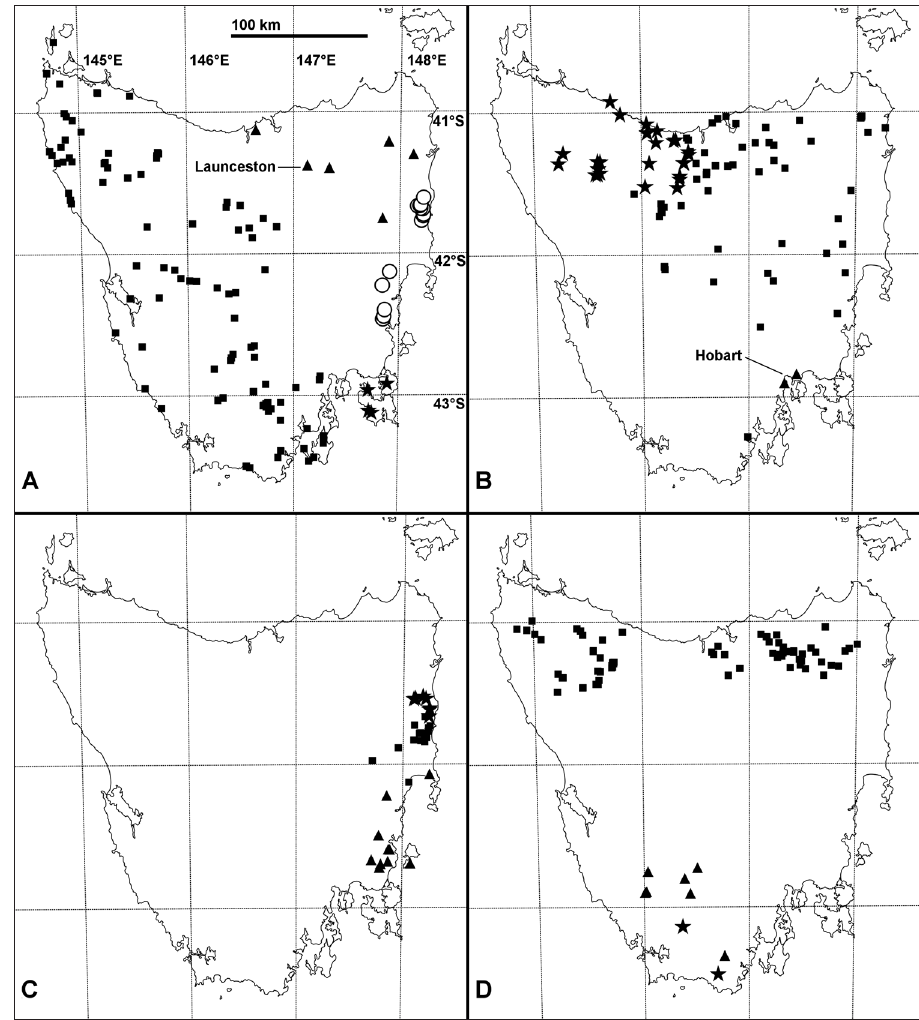
Figure 7. Known localities as of 14 July 2016 for Tasmanian Iulomorphidae; Mercator projections with approximate distance scale. A Amastigogonus orientalis sp. n. (open circles), A. peninsulensis sp. n. (stars), A. tasmanianus Brölemann, 1913 (triangles), A. verreauxii (Gervais, 1847) (squares) B Amastigogonus fossuliger Verhoeff, 1944 (squares), A. hardyi (Chamberlin, 1920) (triangles), A. hellyeri sp. n. (stars) C Amastigogonus danpicola sp. n. (squares), A. elephas sp. n. (stars), A. michaelsae sp. n. (triangles) D Atelo- mastix bonhami sp. n. (triangles), A. smithi sp. n. (stars), Equestrigonus tasmaniensis gen. n., sp. n. (squares). Amastigogonus hellyeri sp. n. http://zoobank.org/FF20C7F6-F918-4BD8-B912-F25F8BDF1EF2 Figs 4D, 6E Holotype. Male, Keddies Creek area, Tas, -41.1704 146.0545 ±25 m, 60 m a.s.l., 7 May 2016, R. Mesibov, QVM